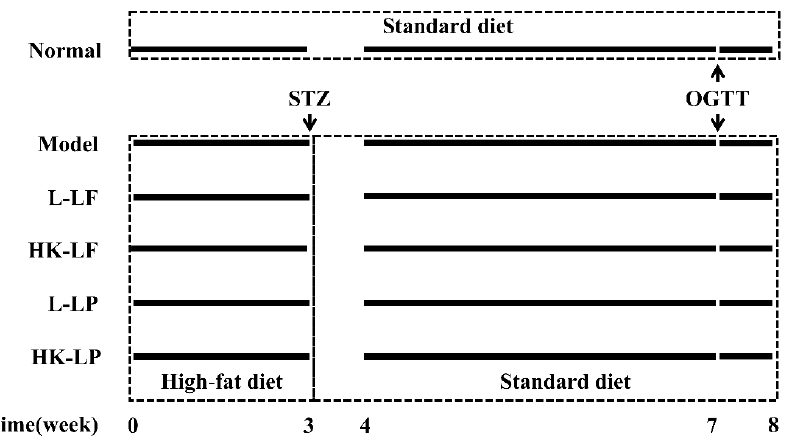
Figure 1. Schematic of the experimental procedure. L-LF: live LF group; HK-LF: heat-killed LF group; L-LP: live LP group; HK-LP: heat-killed LP group; LF: Lactobacillus fermentum ; LP: Lactobacillus plantarum